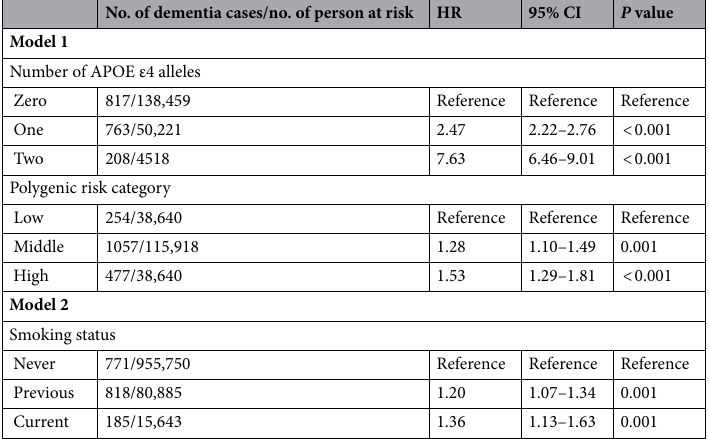
Table 2. Risk of incident dementia according to APOE genotype, polygenic risk and smoking status. Model 1 and Model 2 were adjusted for age, sex, educational attainment, deprivation quantile, BMI, alcohol-intake status, parental dementia status and 5 principal components of ancestry, respectively. HR hazard ratio, CI confidence interval.